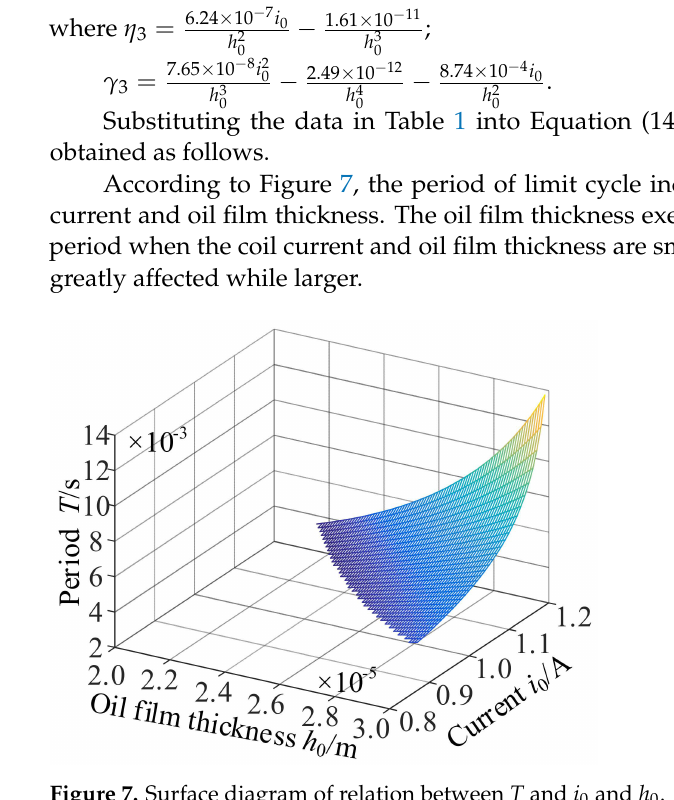
Figure 7. Surface diagram of relation between T and i 0 and h 0